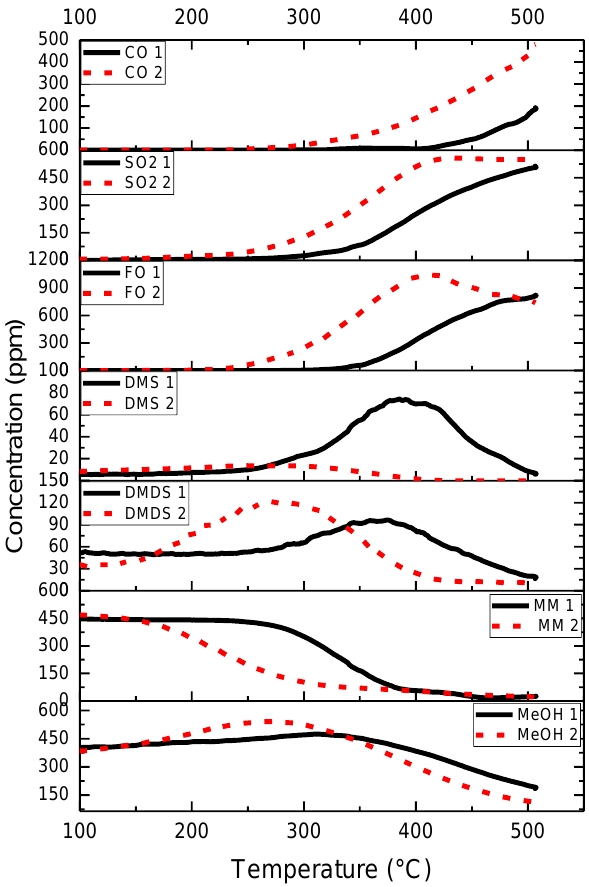
Figure 12. Formation of by-products in the oxidation of the mixture of methanol and methyl mercaptan (500 ppm + 500 ppm) over the SiTi(30) support(1) and 1.5V/SiTi(30) catalyst(2) (feed 500 ppm + 500 ppm, heating rate of 5 °C min −1 ).